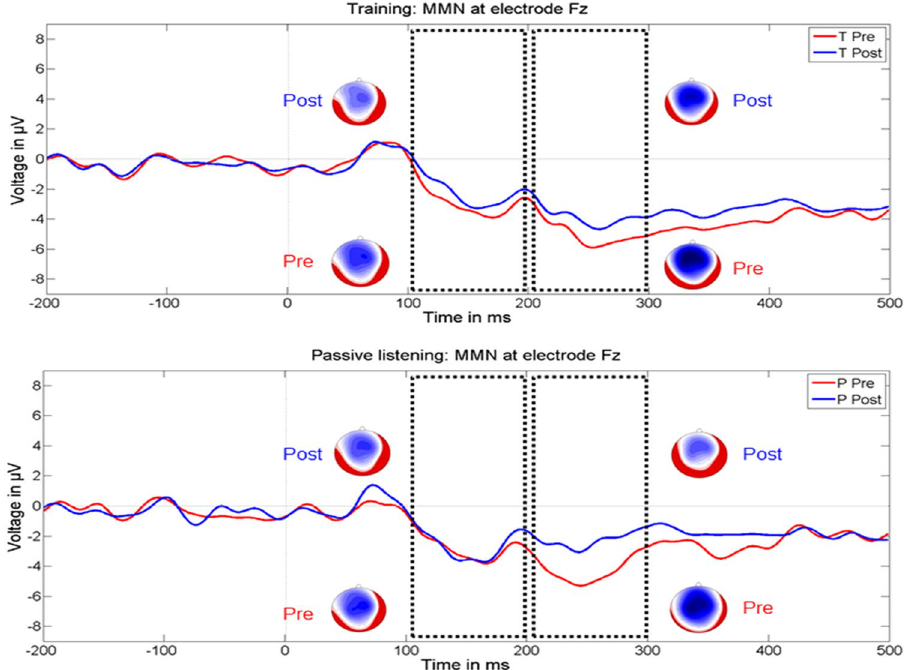
Figure 5. Grand-average MMN responses to spectral (early) and temporal (late) manipulations within the TG (upper part) and the PG (lower part) at T0 (pre, red line) and T1 (post, blue line). The black boxes indicate the time windows of analyses for both the early (100–200 ms) and the late (200–300 ms) MMN with the respective topographies. All waveforms are depicted at electrode FCz.